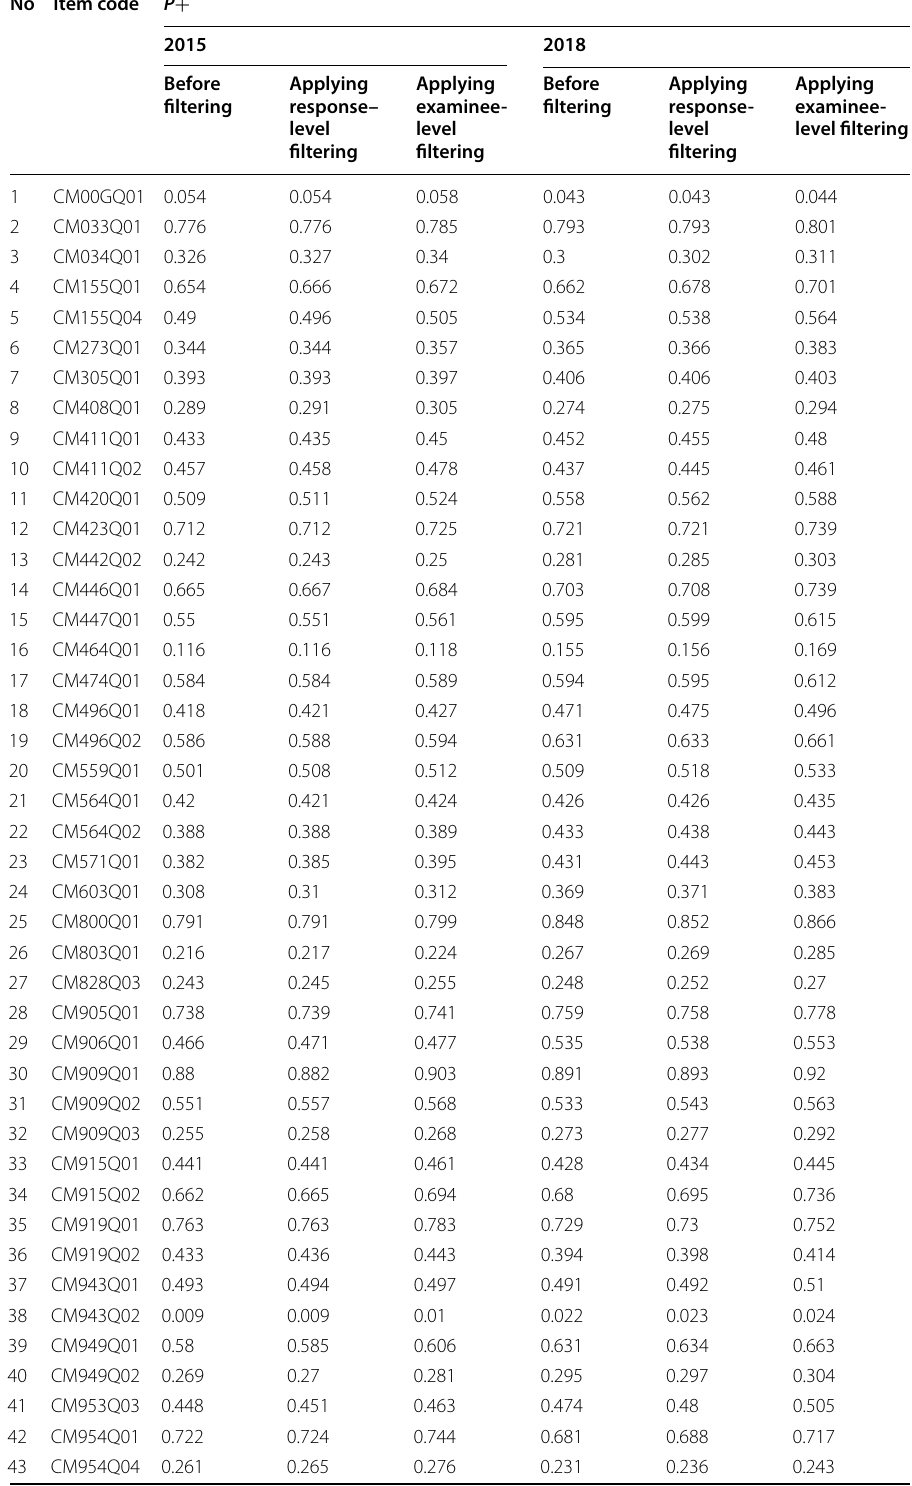
Table 5 Comparison of P in 2015 and 2018. Source : Organisation for Economic Co-operation + and Development (OECD), Programme for International Student Assessment (PISA), 2015 and